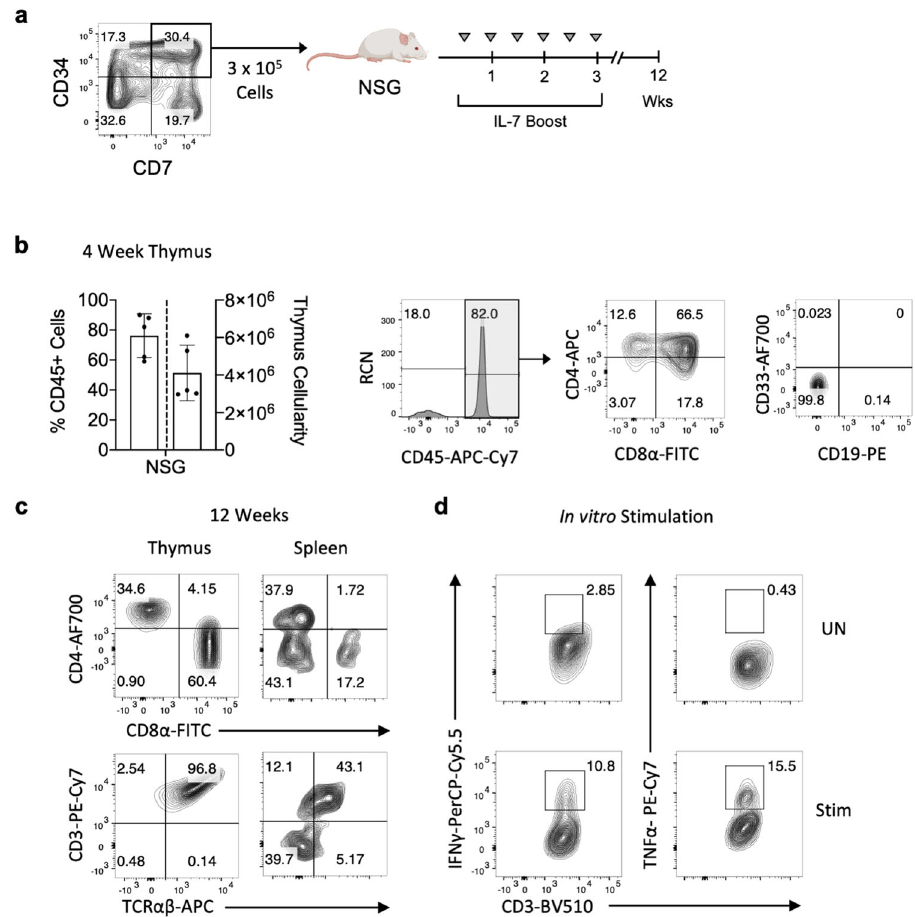
Fig. 5 Engraftment and differentiation of human proT cells in NSG mice. a Schematic of CB-derived proT into neonatal NSG mice. CD34 + cells derived from human CB were incubated with DL4- µ beads for 7 days. CD34 + CD7 + progenitor T (proT) cells were sorted using fl ow cytometry and 3 × 10 5